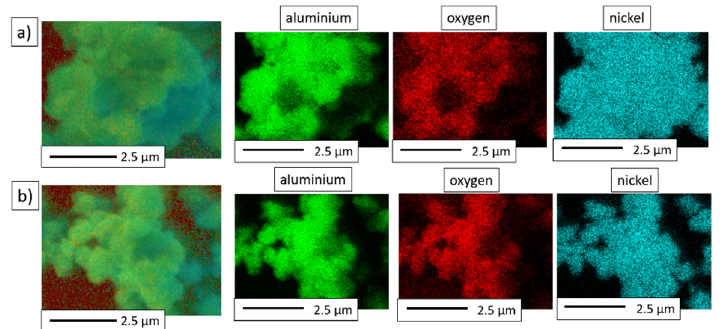
Figure 5. EDS maps of the powder particles of the MA products: ( a ) NiAl-10%Al 2 O 3 powder; ( b ) NiAl-20%Al 2 O 3 powder.